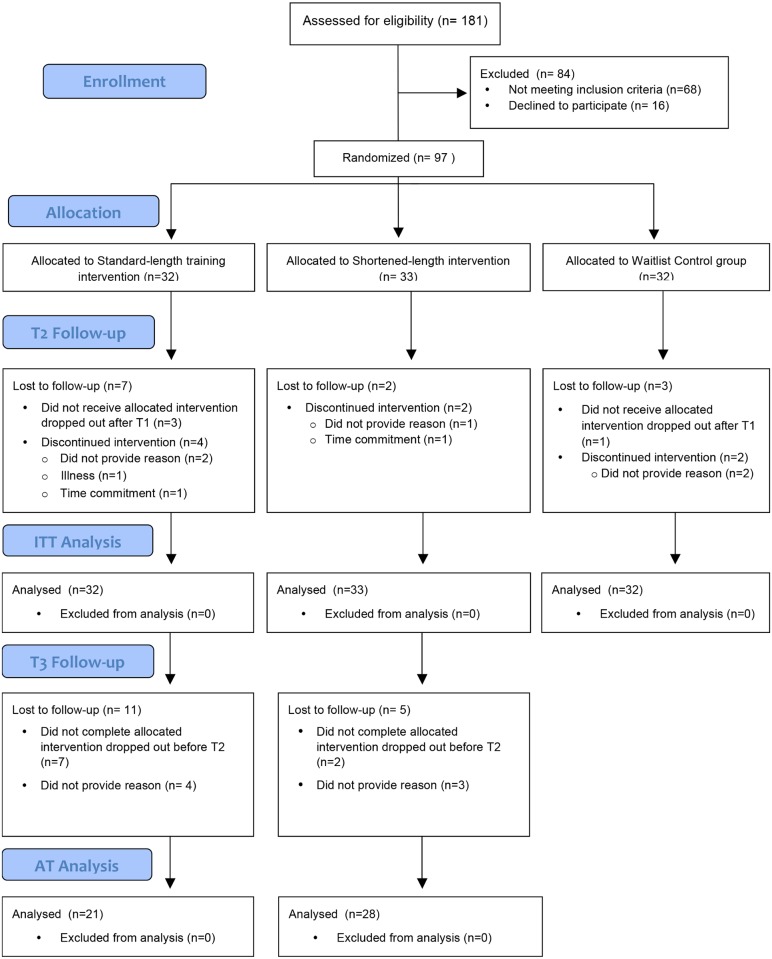
CONSORT Diagram.